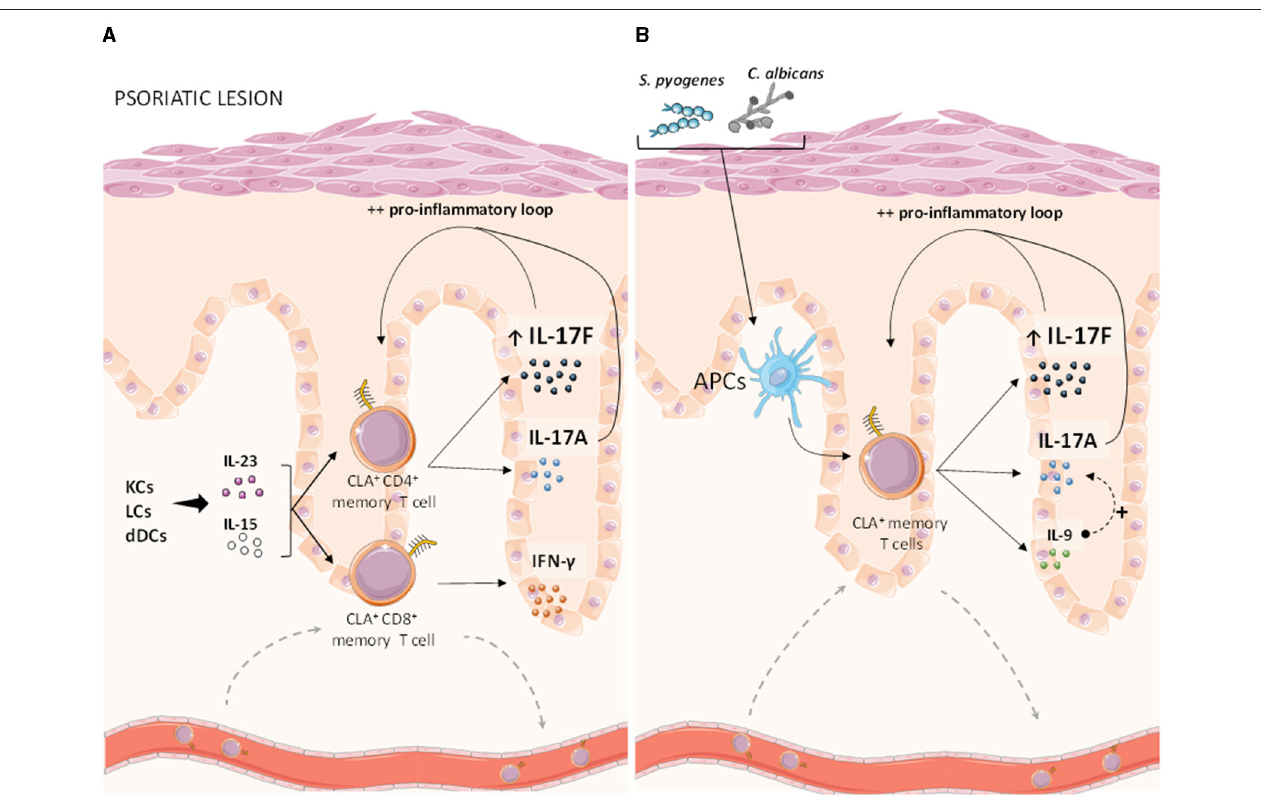
FIGURE 1 | Human CLA + memory T cells and cytokines in psoriasis. As the subset of memory T cells associated to the cutaneous immune system, circulating CLA + T cells are key responders to lesional pro-inflammatory cytokines and relevant microbes that induce important type 17 responses, therefore contributing to the pro-inflammatory loop leading to the appearance of psoriatic lesions. (A) IL-15 and IL-23, which are mainly produced by keratinocytes as well as epidermal and dermal dendritic cells, synergistically activate CLA + CD4 + memory T cells from psoriasis patients leading to an increased induction of IL-17F and IL-17A cytokines, whereas IFN- γ secretion is likely mediated by CLA + CD8 + memory T cells in psoriasis but also in healthy controls. (B) S. pyogenes and C. albicans antigens, presented by epidermal antigen presenting cells, have been proved to induce significantly higher IL-17A/F and IL-9 responses by CLA + memory T cells in psoriasis patients, compared to CLA − T cells. Besides, S. pyogenes- induced IL-9 has shown to enhance IL-17A responses, further reinforcing the pro-inflammatory loop underlying psoriasis lesions. CLA, cutaneous leukocyte-associated antigen; KCs, keratinocytes; LCs, Langerhans cells; dDCs, dermal dendritic cells; APCs, antigen presenting cells. This figure was created using Servier Medical Art (smart)